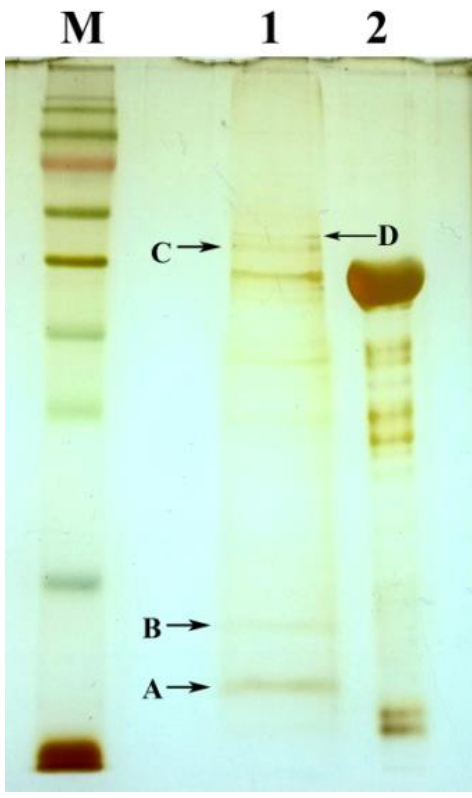
Figure 6. The PAGE analysis on Tb -DdlA interaction partners obtained by pull-down assay. The gel was stained by silver staining. M , PageRuler prestained protein ladder (Fermentas), the band sizes from top to bottom are 180 kDa, 130 kDa, 100 kDa, 70 kDa (red), 55 kDa, 40 kDa, 35 kDa, 25 kDa, 15 kDa, and 10 kDa, respectively; 1 , Tb -DdlA interaction protein complexes obtained by pull-down assay; 2 , Tb -DdlA purified by Ni 2+ -NTA affinity chromatography. A – D , the bands selected for MS identification.